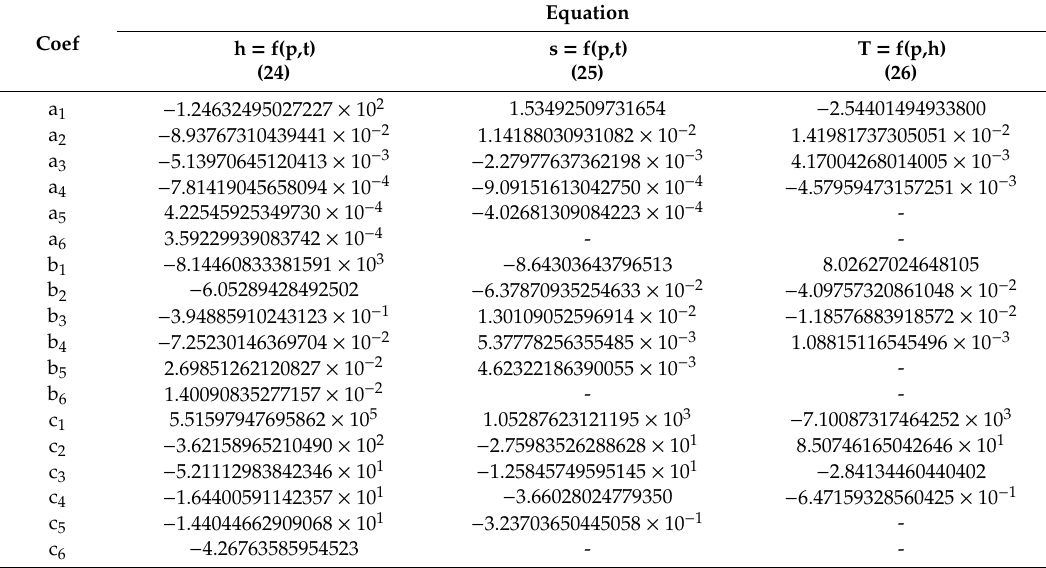
Table 10. Coe ffi cients of polynomials describing the properties of the R1234ze(E) refrigerant in